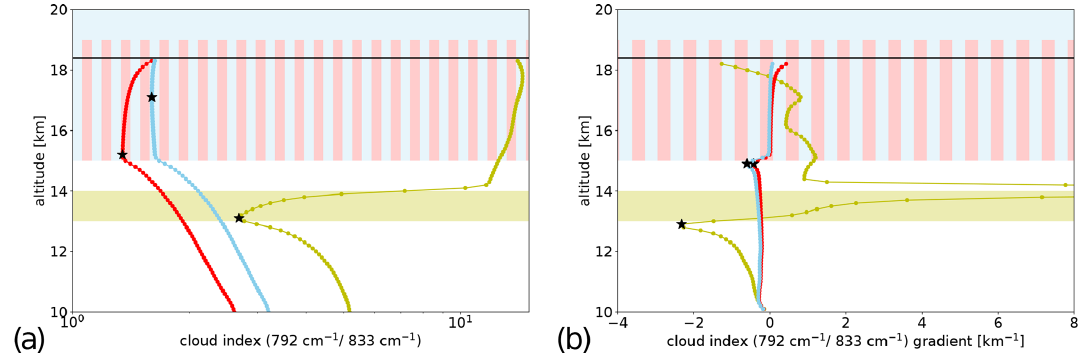
Figure 7. Vertical profiles of the cloud index (a) and the vertical gradient of the cloud index (b) for clouds with different vertical thicknesses. The colour coding shows the vertical thickness (yellow: 1km; red: 4km; light blue: from 8 to 23km). The HNO 3 VMRs inside the NAT PSCs are 5ppbv for the 1 and 8km thick clouds and 10ppbv for the 4km thick cloud. The corresponding shaded areas illustrate the vertical extent of the clouds. The black stars mark the altitudes of the CI minima and the CI gradient minima. The black horizontal line shows the flight